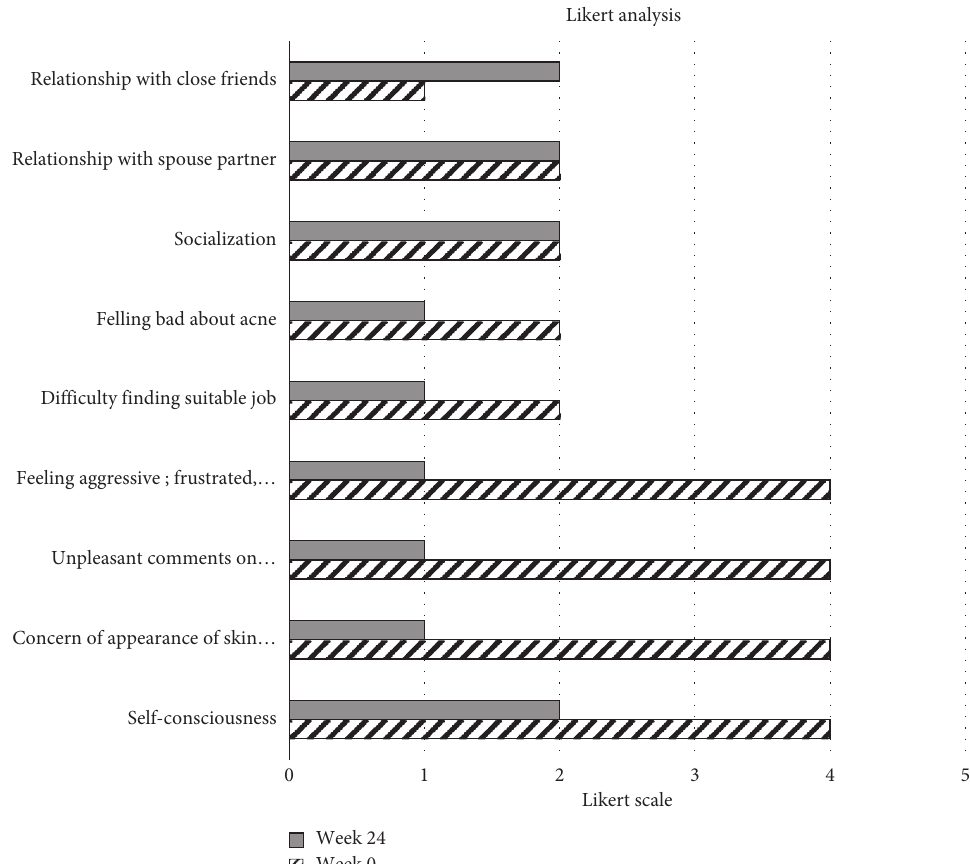
Figure 8: Likert scale analysis (scale of 0–5) for psychological assessment of patients with acne following treatment. The assessment parameters are listed on the left, and the bars correspond to the response at week 0 or at week